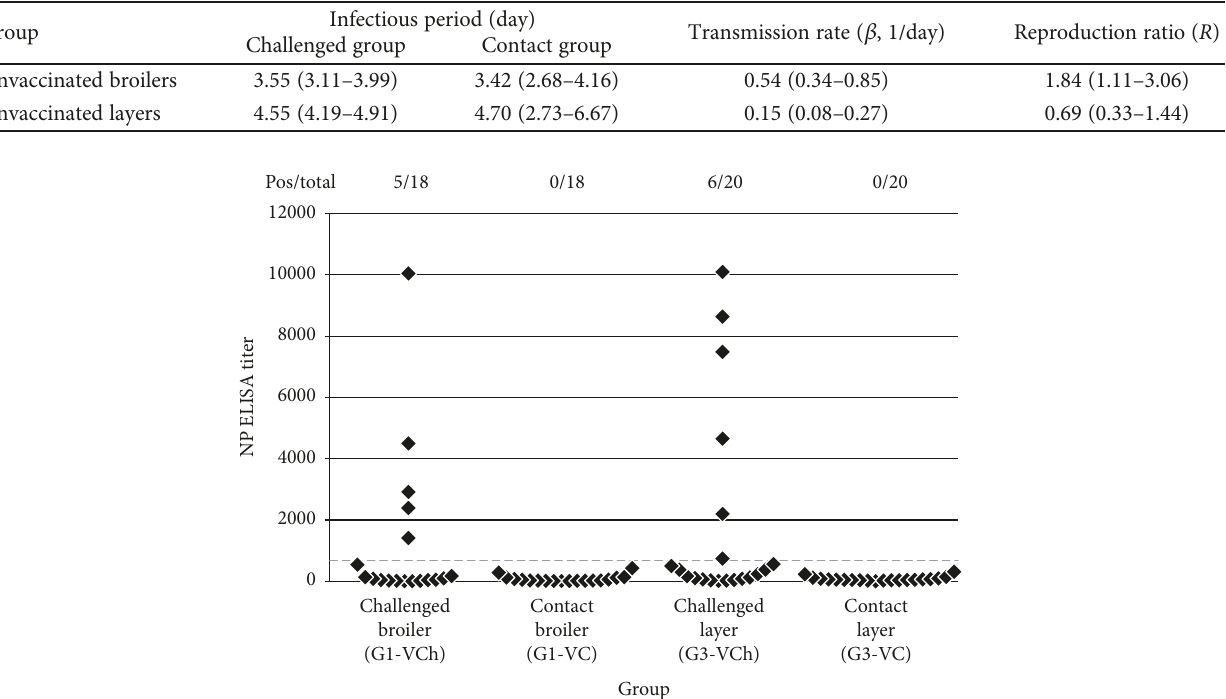
Table 2: Overview of the statistical analyses (95% CI in brackets).